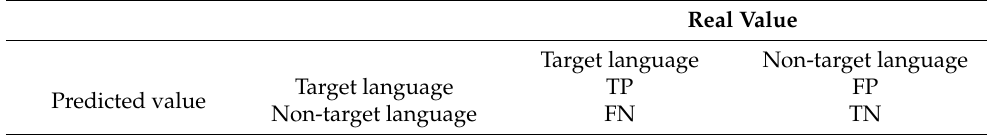
Table 3. Identification result